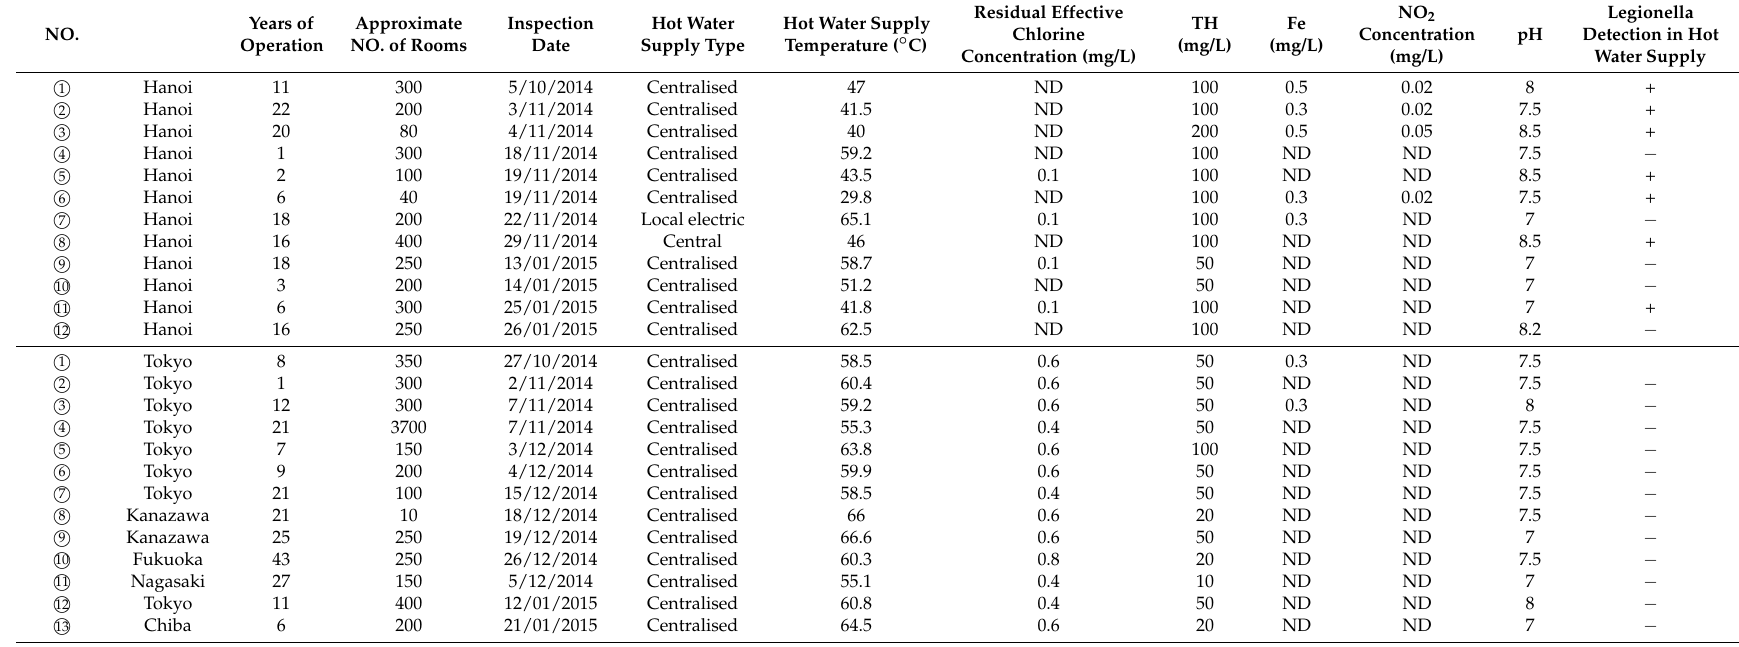
Table 1. Analysis results showing hot and cold water supplies’ water quality in hotel rooms in Vietnam and